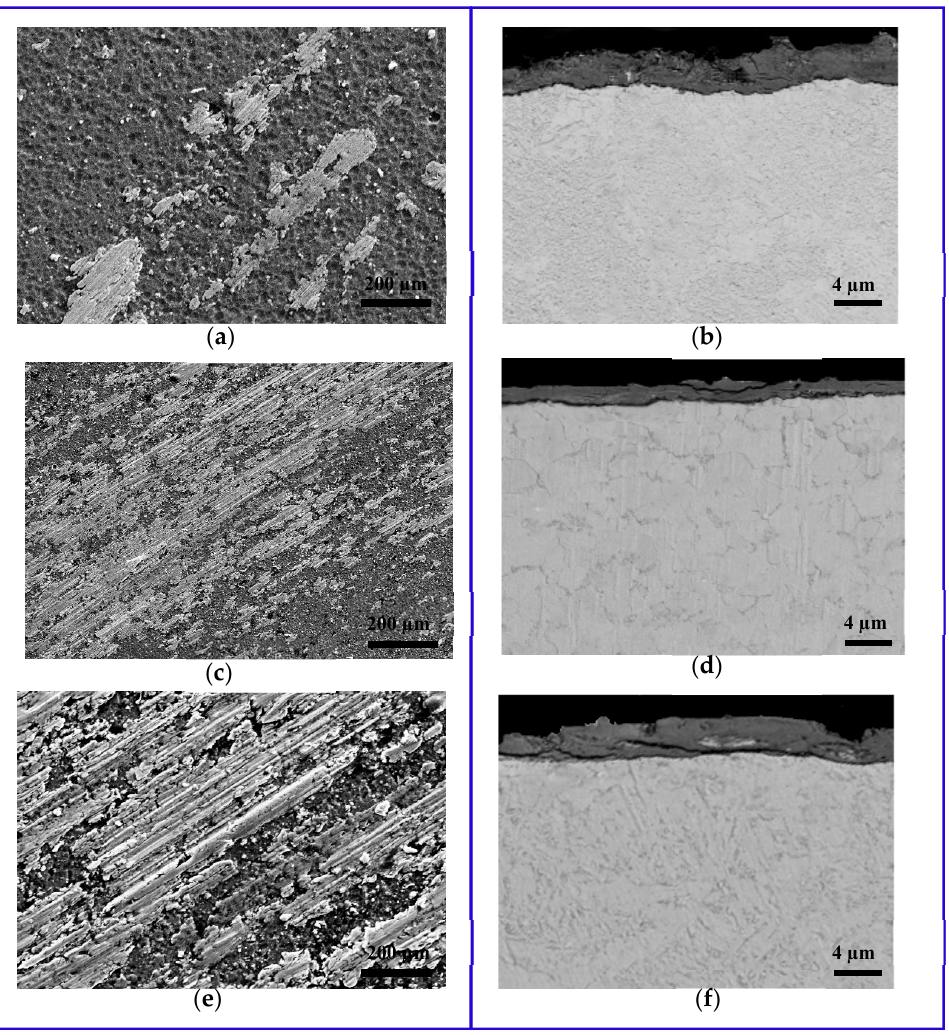
Figure 10. SEM Images of the mold’s surface topography ( a , c , d ) and core pins cross section ( b , d , f ) after the HPDC tests. AlCrN/Si 3 N 4 ( a , b ); AlTiN/Si 3 N 4 ( c , d ) and AlCrN ( e , f ).